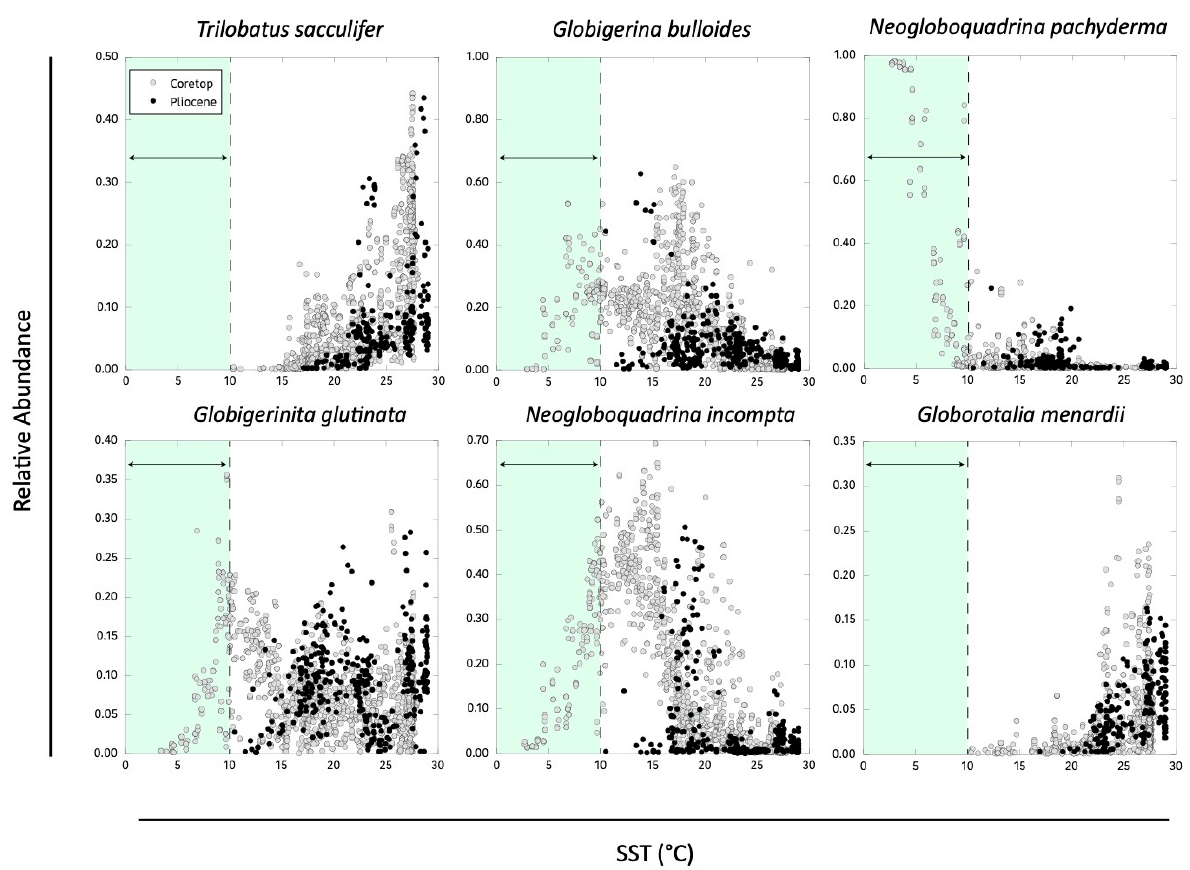
Figure 3. Comparison of extant species found in the North Atlantic. Scatter plots of relative abun- dance and alkenone-based SSTs for six extant species showing core-top (gray) and Pliocene (black) distribution. Dashed vertical lines at 10 ◦ C indicate the lower temperature limit of Pliocene North Atlantic data. Horizontal arrows and green shading highlight the 0 ◦ C to 10 ◦ C region of only core-top data in each plot.